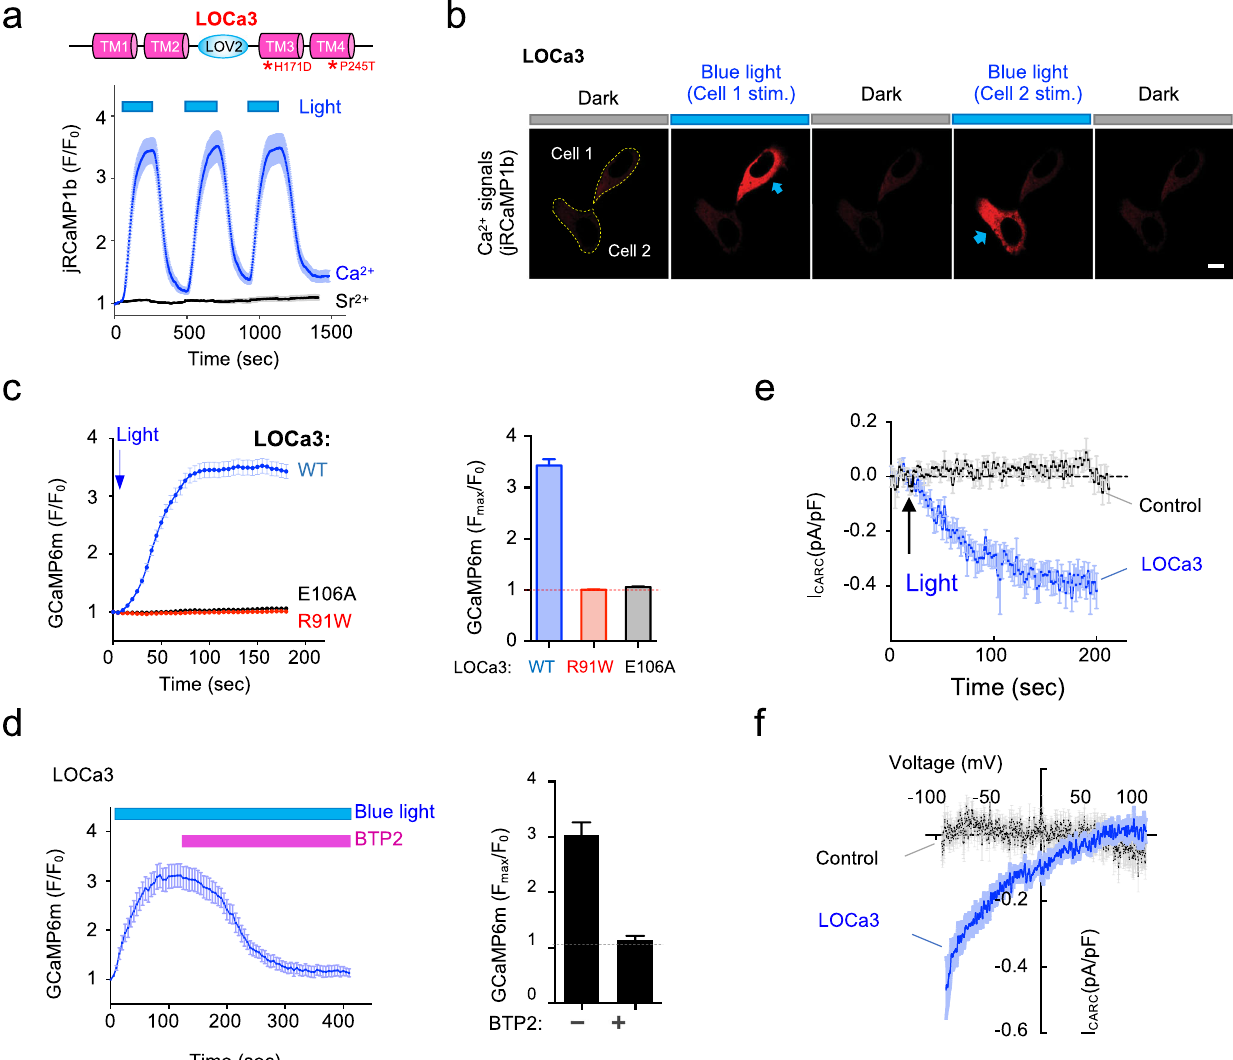
Fig. 2 Characterization of LOCa3 in mammalian cells. Data are shown as mean ± s.e.m. a A typical reversible in fl ux of Ca 2 + (blue), but not Sr 2 + (black), reported by a red genetically encoded Ca 2 + indicator (jRCaMP1b) in ORAI-null HEK293 cells transfected with LOCa3. Cells were cultured in an imaging buffer containing 2 mM Sr 2 + or Ca 2 + and then subjected to three repeated light – dark cycles of stimulation. The activation and deactivation half-lives were 48.7 ± 4.5 s and 56.8 ± 3.8 s, respectively. ORAI1 channel is known to uniquely prohibit Sr 2 + in fl ux because of its strict ion selectivity toward Ca 2 + . n = 14- 16 cells from three independent biological replicates. b Spatial control of Ca 2 + in fl ux in two neighboring HeLa cells. Cells in the two indicated regions (dashed lines) were sequentially subjected to photo-illumination using a 488-nm laser (0.5% input). Scale bar, 10 μ m. Also see Supplementary Movie 1. c Comparison of light-induced Ca 2 + in fl ux among the indicated LOCa3 variants. The channel-inactivating mutations R91W and E106A completely blocked photo-triggered Ca 2 + entry. The quanti fi cation of the relative change of GCaMP6m signals after light stimulation is shown in the bar graph on the right. n = 48-52 cells from three biological replicates. d . BTP2 as a CRAC channel blocker effectively suppressed blue-light-induced Ca 2 + in fl ux. Left, the time- course of GCaMP6 fl uorescence. Right, quanti fi cation of the GCaMP6 signals before and after BTP2 treatment (5 μ M). n = 10 cells. e . The mean time- courses of whole-cell currents in HEK cells expressing LOCa3 or a control vector following exposure to blue light illumination. n = 8 – 9 cells. f . Mean current-voltage relationships at the peak of light-induced currents ( n = 8